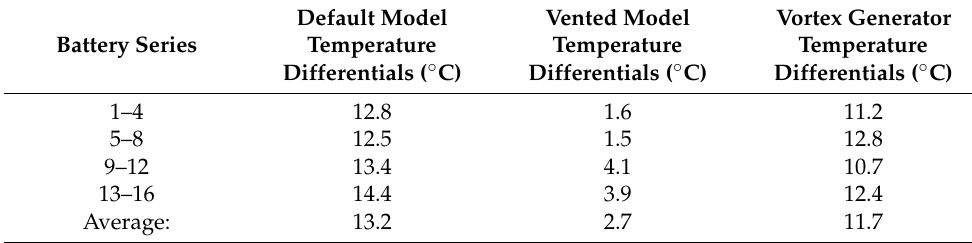
Table 7. Temperature differentials across battery series for each of the three models.